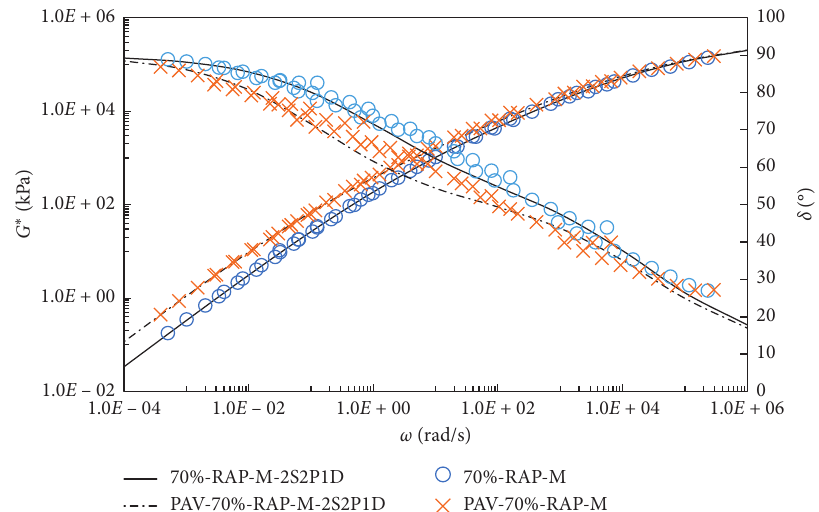
Figure 10: Complex shear modulus and phase angles master curves for RAP-M binder containing 70% RAP binder before and after PAV